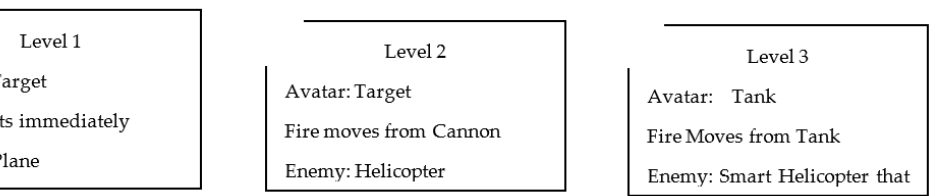
Figure 20. Different levels of the ShootDown demo game.